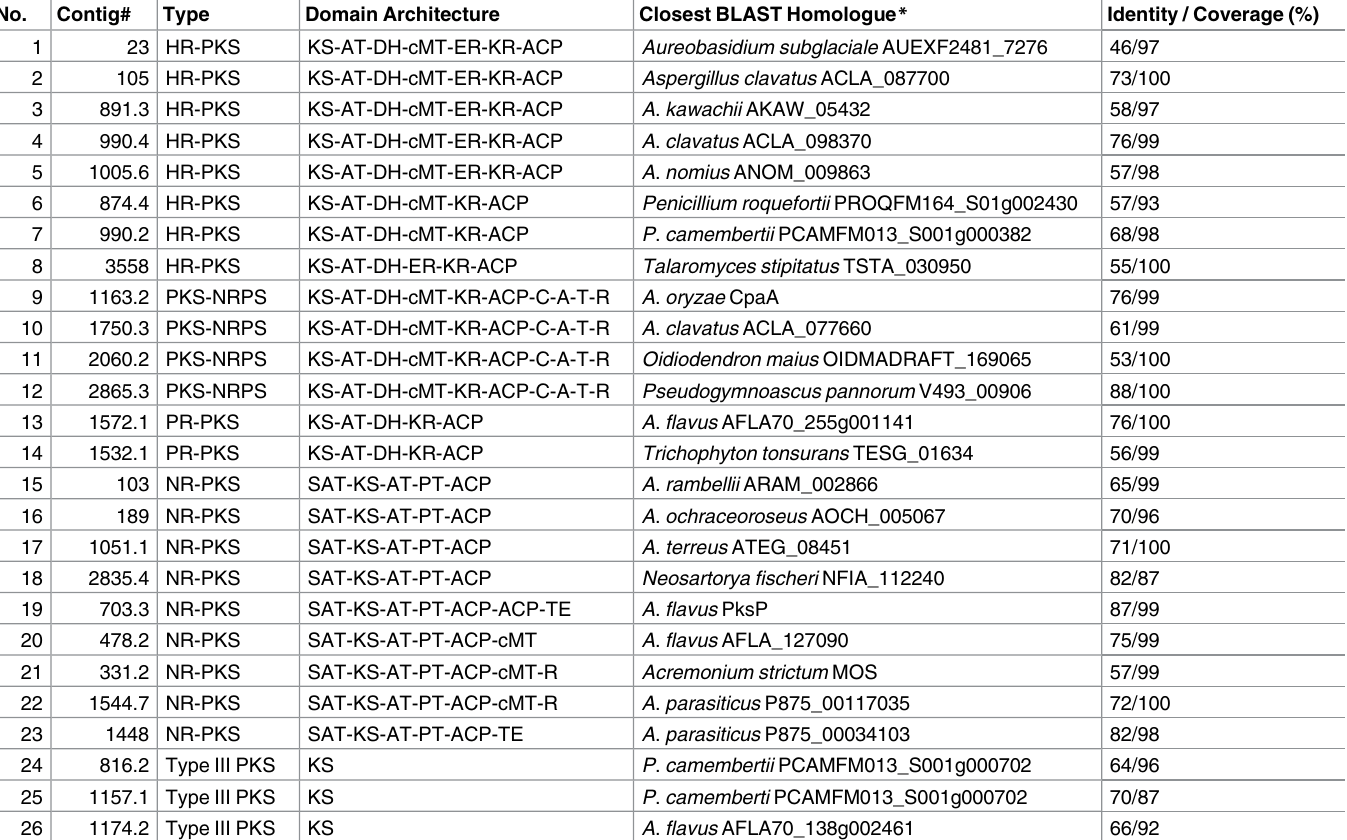
Table 4. Polyketide synthases (PKS) encoded in the A . hancockii genome.